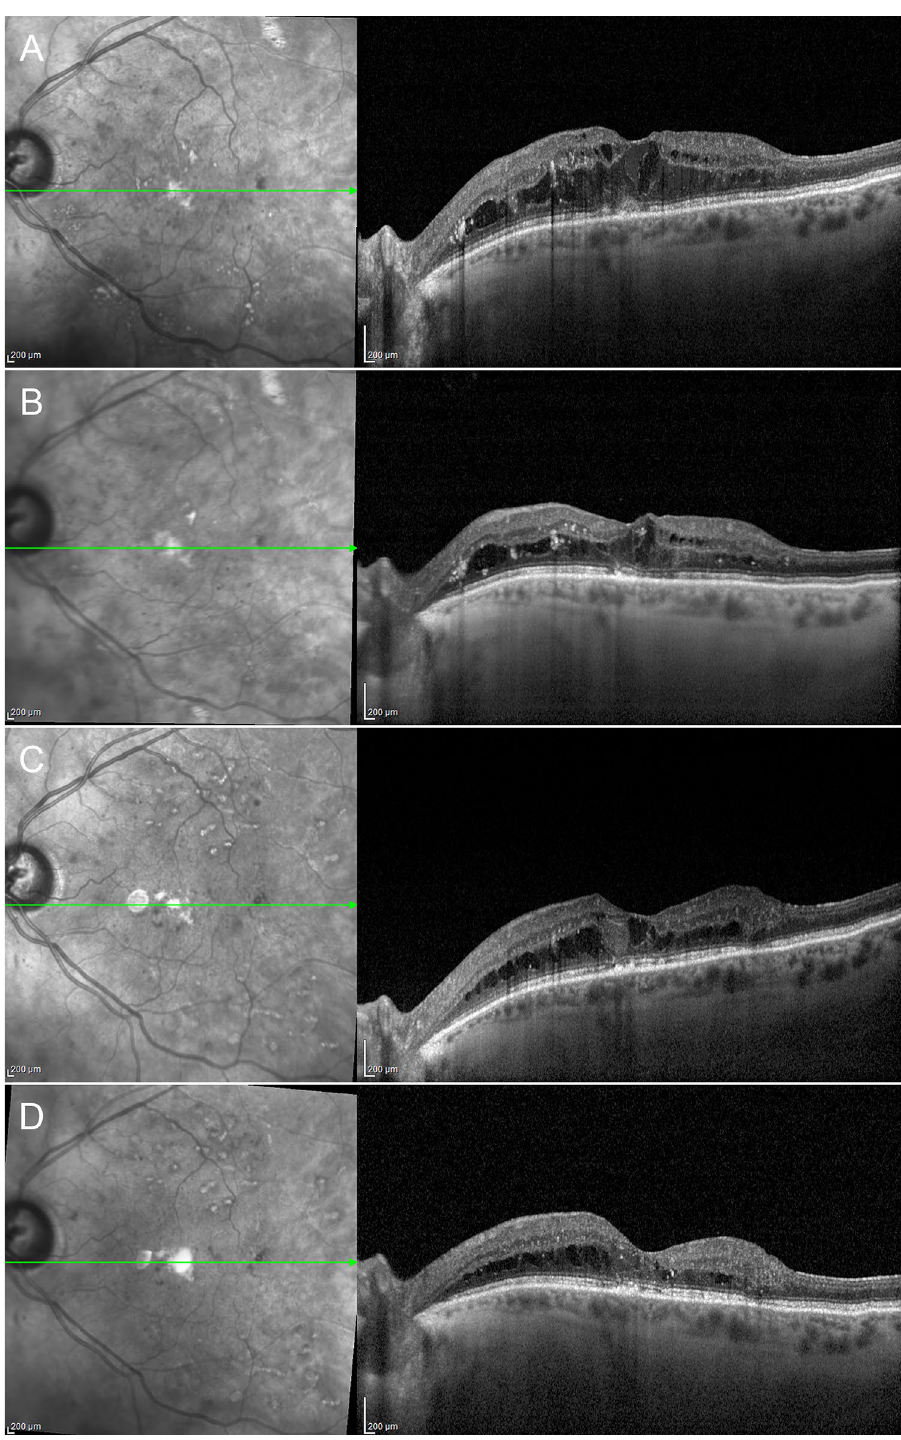
Figure 5. A case of diabetic macular edema with no foveal eversion. Baseline examination shows a DME with no everted foveal profile ( A ). The clinical evolution of this case is characterized by a persistence of the intraretinal fluid ( B , C ) (6-month and 9-month F/U, respectively), although the foveal region appears partially spared at the last follow-up ( D